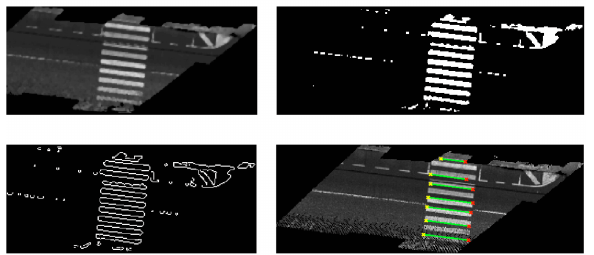
Figure 11 shows an example of a correctly detected zebra crossing. Some zebra crossing were not detected, although false positives are not presented in the results.